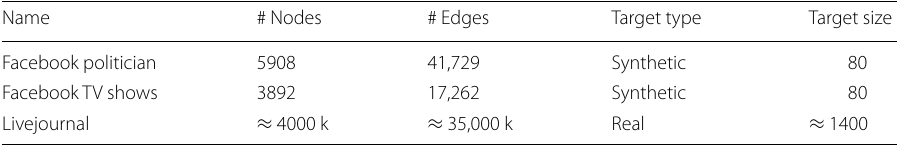
Table 3 Characteristics of the real networks and corresponding target